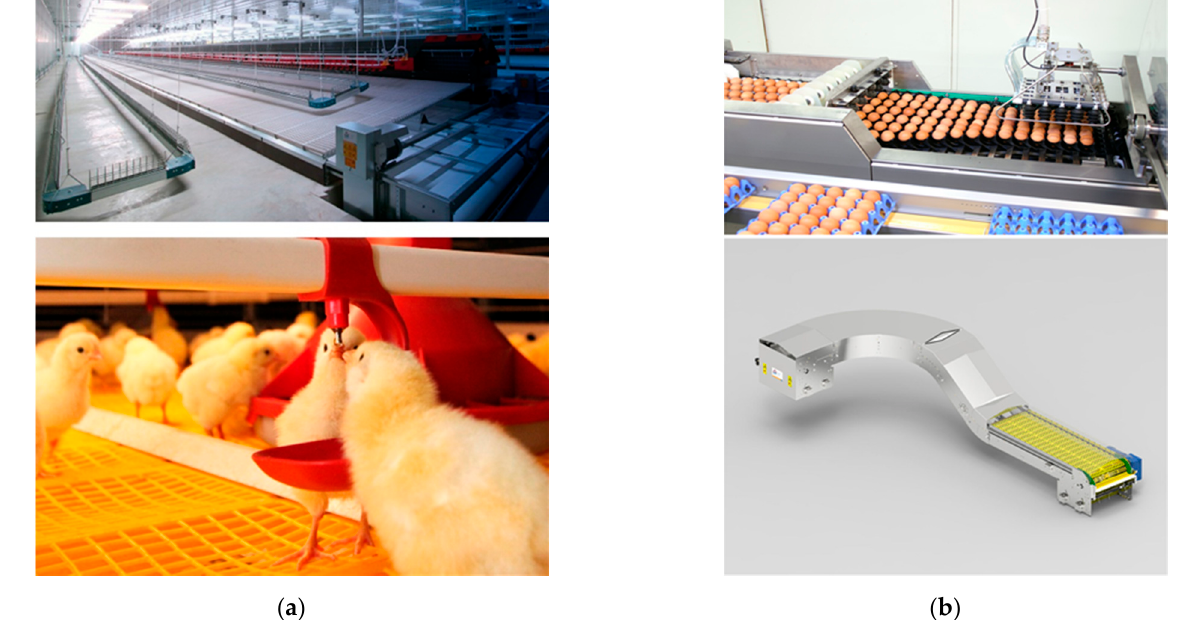
Figure 5. Chicken house equipment. ( a ) is the chain feeding systems (Source: Jansen Poultry Equipment). ( b ) is the egg collection systems (Source: Jansen Poultry Equipment).